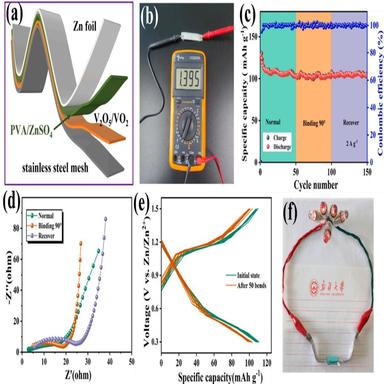
(a) Schematic diagram of the flexible device of a zinc ion battery. (b) The open circuit voltage of the device. (c) Cycle performance before and after bending at 2 A g− 1 . (d) The EIS spectra before and after bending. (e) Comparison of voltage-capacity curves after multiple bending. (f) Five red LED lights (1.8 V) powered by two flexible AZIBs connected in series at bend 90◦.